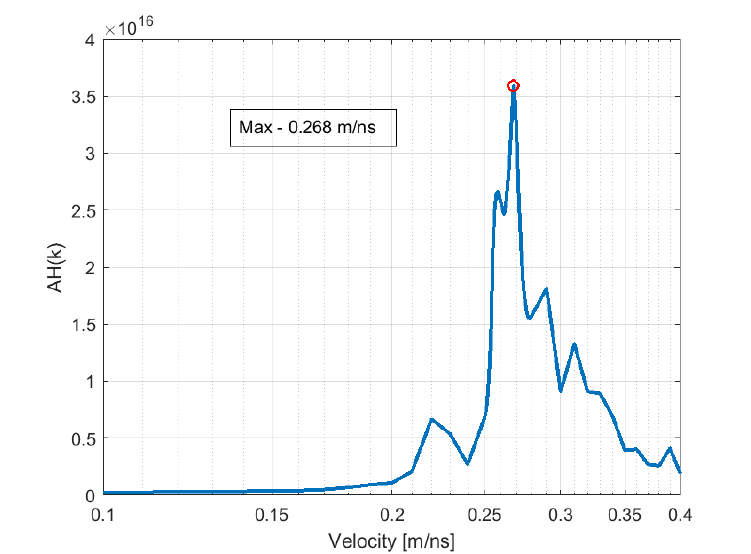
Figure 3. Example of the autofocusing procedure for an image segment with input data ( a ), undermigrated data ( b ), migration result from autofocusing at optimum value ( c ), and an overmigrated image ( d ).